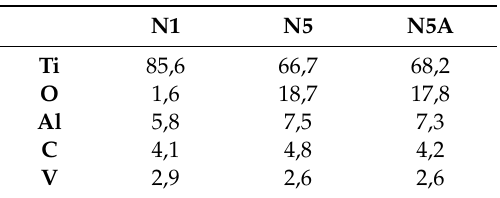
Table 3. Elemental composition of N1, N5, N5A samples as derived from EDS analyses. The data are expressed as percentage of weight (wt%). N1 N5